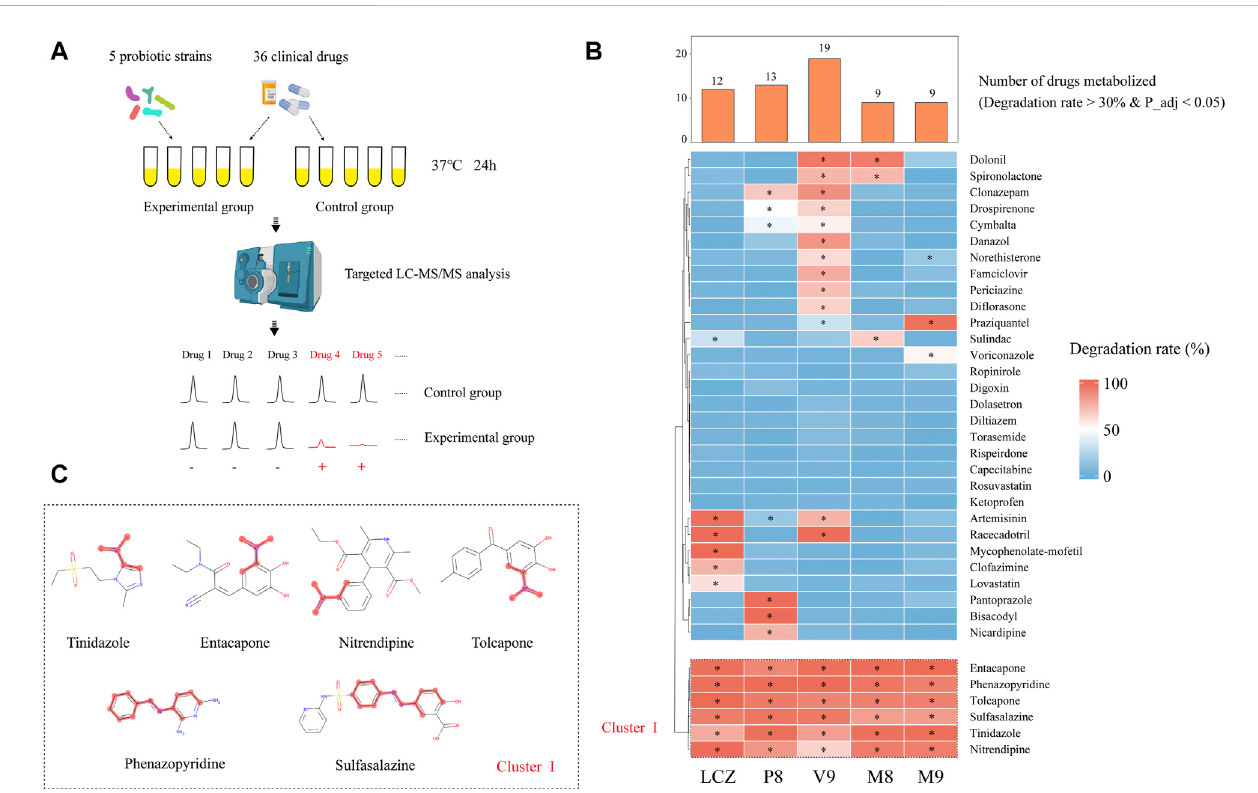
FIGURE 1 Drug-metabolizing activities of probiotics. (A) Schematic illustration of the assay. (B) Heat map showing the capacity of fi ve probiotic strains ( Lacticaseibacillus casei Zhang, LCZ; Lactiplantibacillus plantarum P8, P8; Bi fi dobacterium animalis subsp., lactis V9, V9; B. animalis subsp. lactis Probio-M8, M8; Lacticaseibacillus rhamnosus Probio-M9, M9) in metabolizing 36 drugs. Hierarchical clustering analysis was performed based on degradation rate, and ClusterIcompriseddrugsthatcouldbemetabolizedbyall fi veprobioticstrains.Thebarchartshowsthenumberofdrugsmetabolizedbyeachprobiotic strain. * adjusted p < 0.05, Wilcoxon test. (C) Chemical structure of the six cluster I drugs. The common substructures of these drugs are shown in red, i.e., a nitro group in entacapone, tolcapone, tinidazole, and nitrendipine; and an azo group in phenazopyridine and